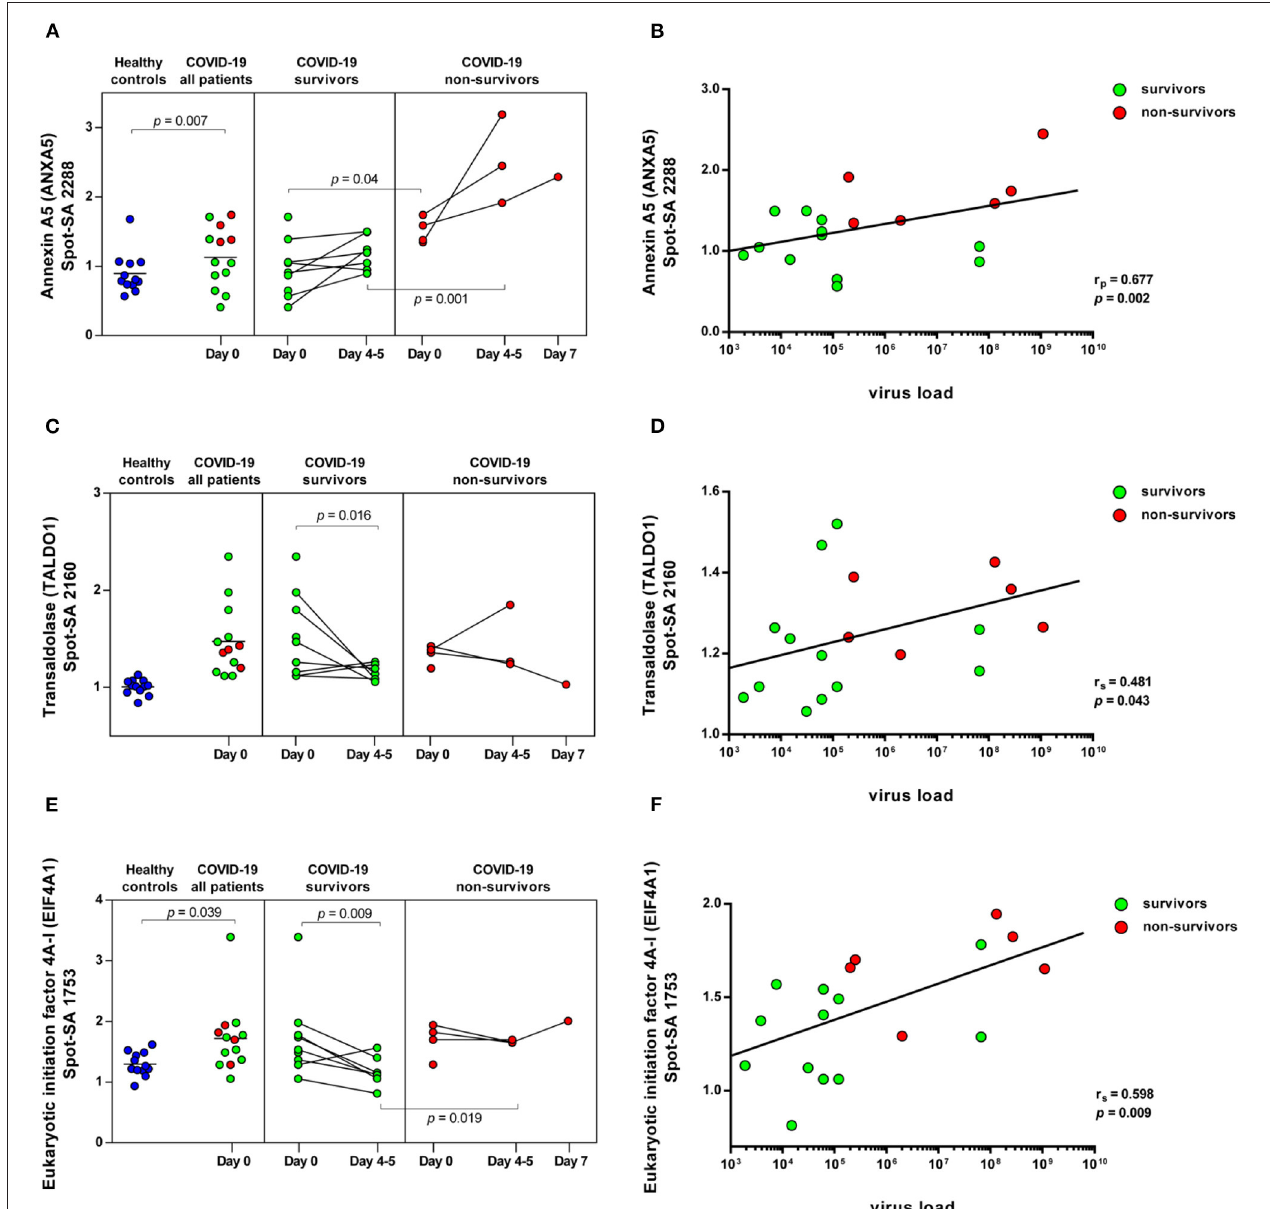
FIGURE 5 | COVID-19-dependent course of the abundance of ANXA5, TALDO1 and EIF4A1 in platelets. Scatter dot plot and time course of ANXA5, TALDO1, and EIF4A1 standardized platelet protein spot abundance in COVID-19 patients quantified by 2D-DIGE (healthy controls: n = 12; COVID-19 survivors: n = 9; COVID-19 non-survivors: n = 4) and their correlation with nasopharyngeal virus load. (A) Protein levels of ANXA5 (spot 2288) and (B) scatter dot plot correlation analysis (Pearson’s Rank correlation coefficient) of virus load and 2D-DIGE ANXA5 levels. (C) Protein levels of TALDO1 (spot 2160) and (D) scatter dot plot correlation analysis (Spearman’s Rank correlation coefficient) of virus load and 2D-DIGE TALDO1 levels. (E) Protein levels of EIF4A1 (spot 1753) and (F) scatter dot plot correlation analysis (Spearman’s Rank correlation coefficient) of virus load and 2D-DIGE EIF4A1 levels. 2D-DIGE, two-dimensional differential in-gel electrophoresis.